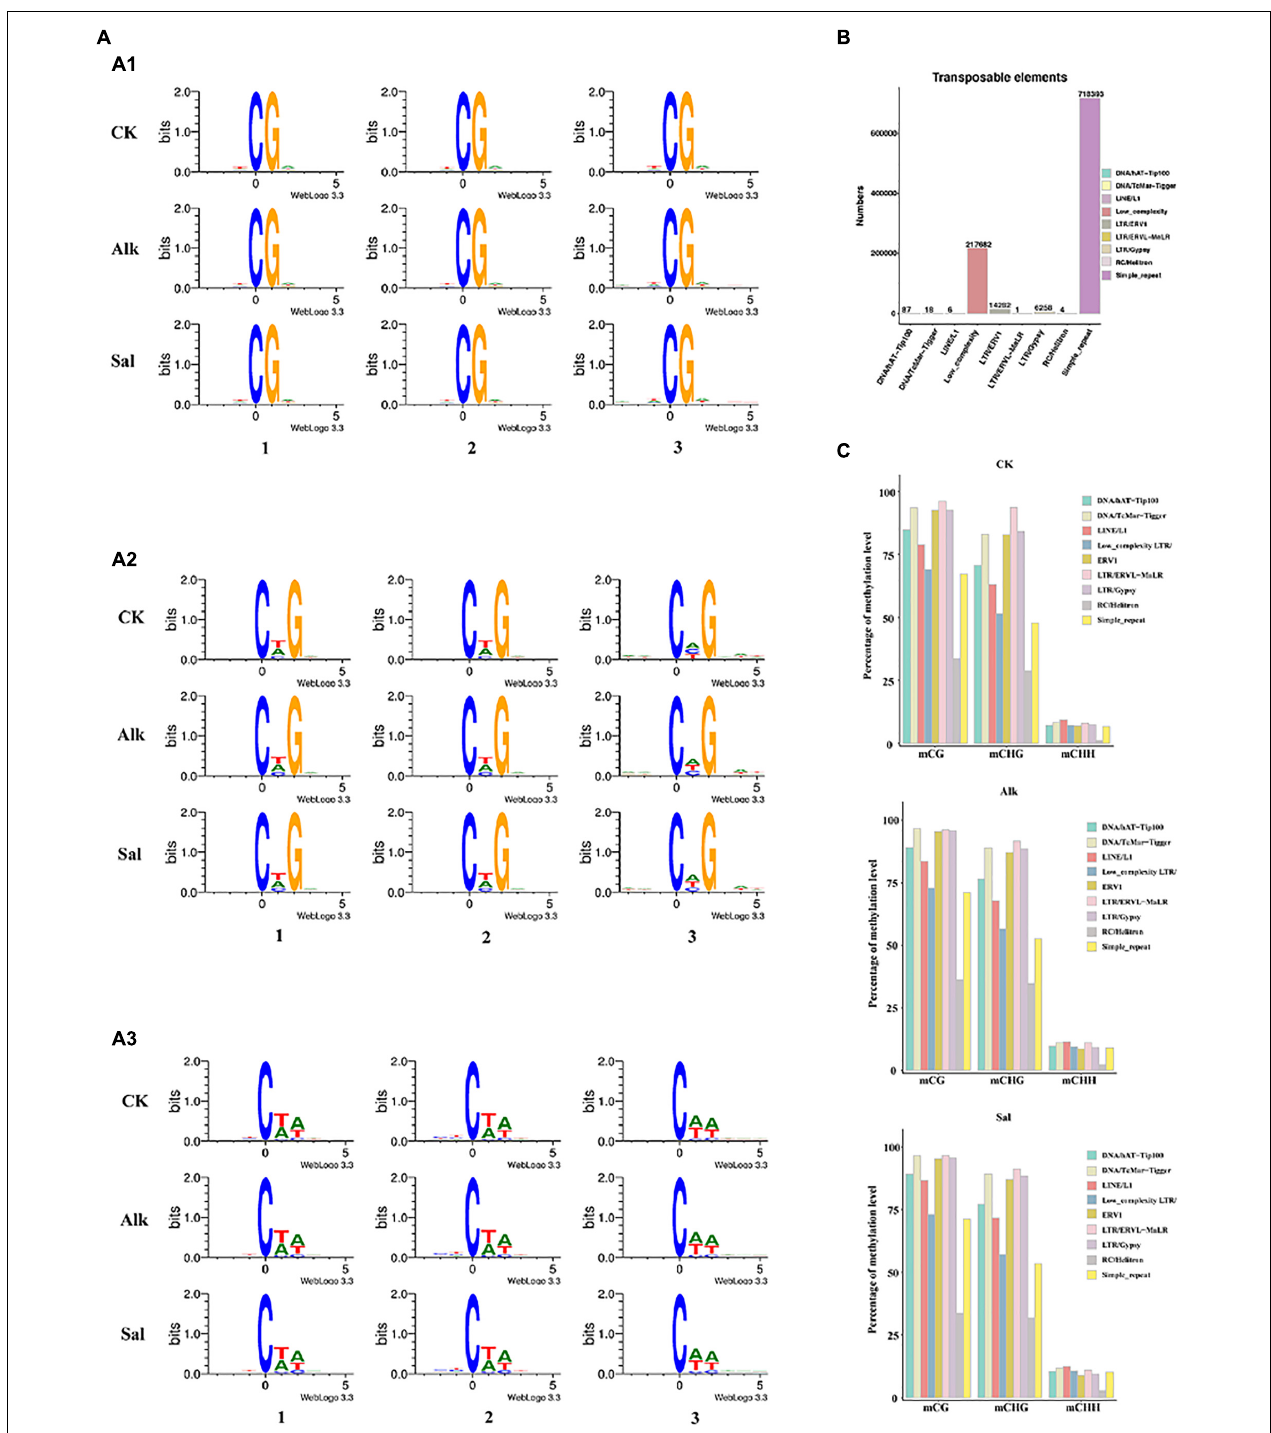
FIGURE 3 | Sequence preference of cytosine DNA methylation and methylation patterns of (TEs) in the G. barbadense genome. (A) Sequence preference of cytosine DNA methylation and differentially methylated cytosines in gene elements. (x) Weblogo analysis of bases around 5-mCs in CG (x), CHG (x), and CHH (x) sequence contexts. The x- axis represents the position of 9-bp sequence information near the 5-mCs; the y -axis represents the conservation of bases at the site, A1, A2 and A3 represent CG, CHG and CHH context, respectively. 1 represent all mC sites, 2 represent high methylation sites (defined > 75% methylation level), 3 represent low methylation sites. In non-CG context, high methylation level sites were defined methylation level > 25% and others were low methylation level sites. (B) Numbers of different types of TEs in G. barbadense genome. (C) Percentage of methylation levels of different types of TEs in three samples.